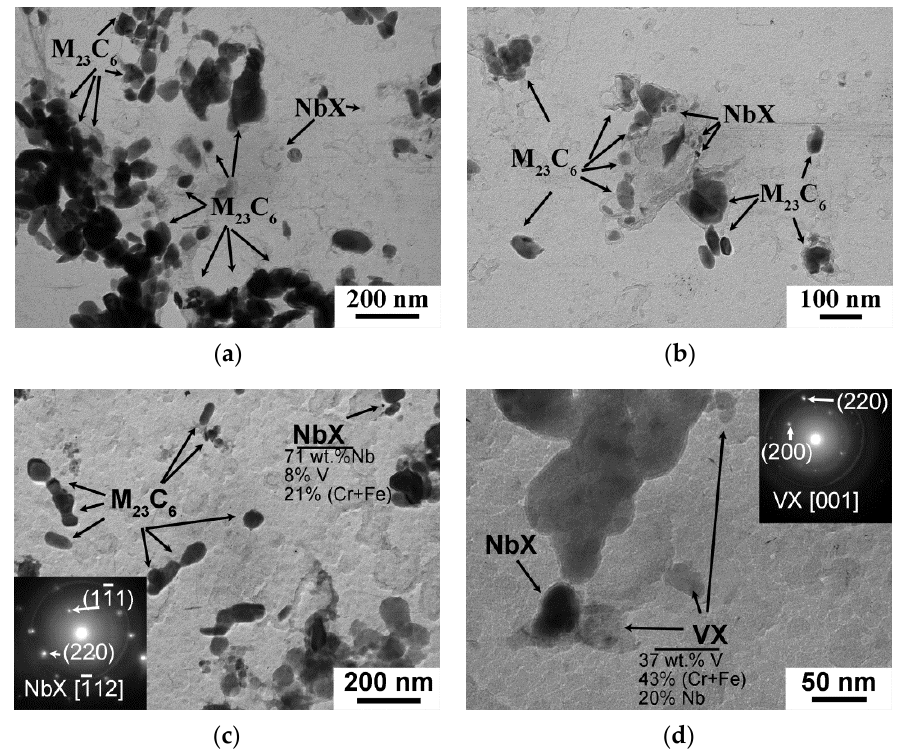
Figure 9. TEM images of the secondary phase particles in the 12CrNb0.003N steel subjected to the CHT ( a , b ) and TMP ( c , d ) obtained using carbon replicas. Table 8. Structural parameters of the 12CrNb0.003N steel after the CHT and TMP.